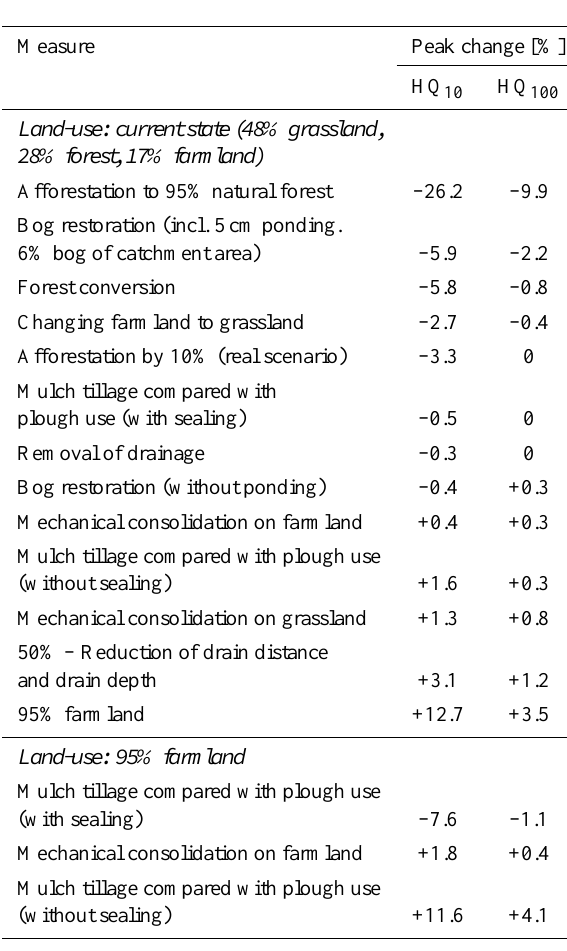
Table 4. Flood Peak Changes in model applications of different distributed flood control measures compared to current